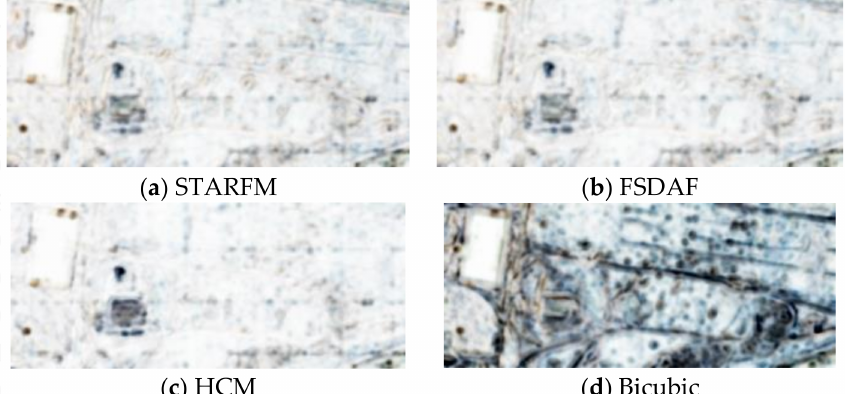
Figure 10. SSIM maps of the Field scenario using different methods. ( a – d ) are the maps for STARFM, FSDAF, HCM, and bicubic,